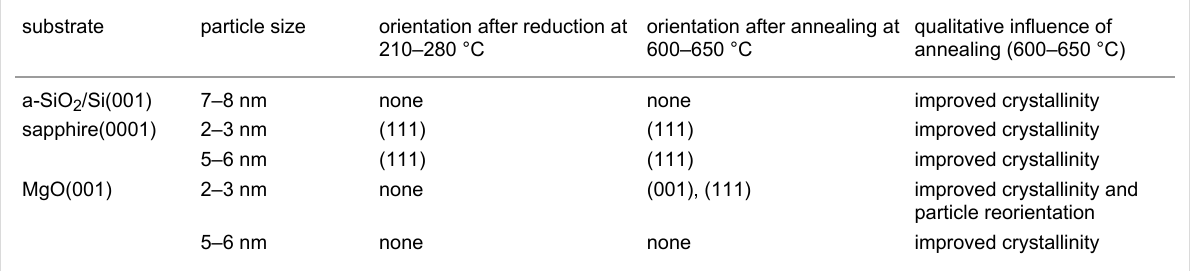
Table 1: Experimental results of the preferred orientations of FePt nanoparticles on various substrates after particle reduction and in situ annealing. The last column summarizes the improvement regarding crystallite growth and